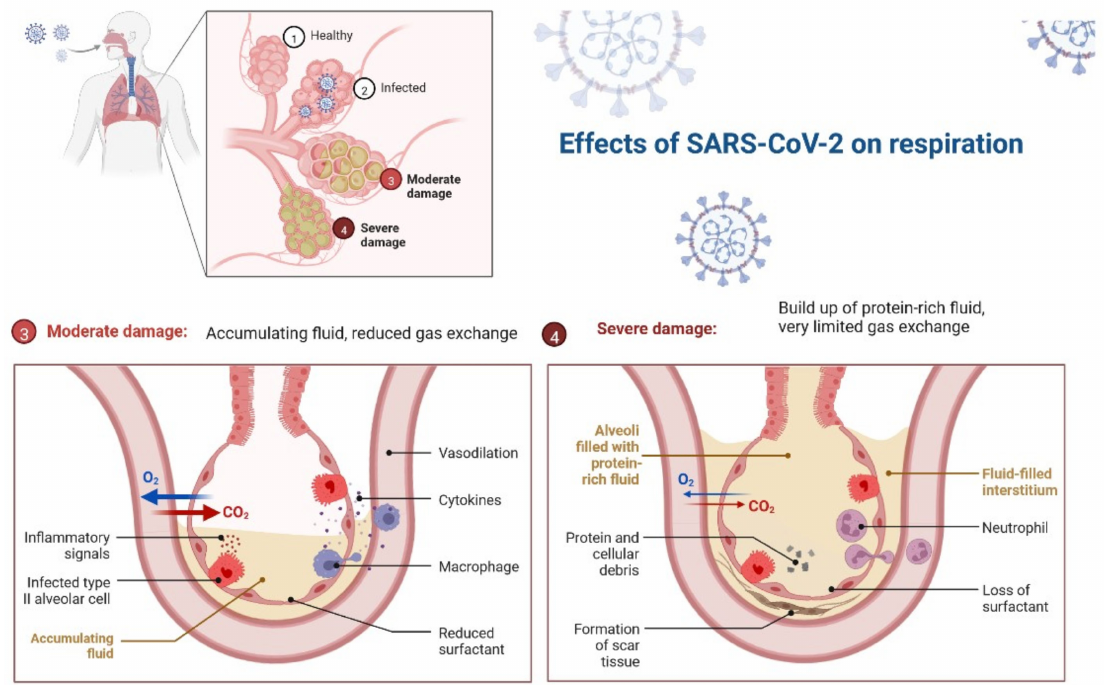
Figure 7. After entering the body through the mouth or nose, SARS-CoV-2 makes its way into the lungs, where it uses its distinctive spike proteins to infect alveolar cells. In response, the immune system attacks the area of infection, killing healthy alveolar cells in the process. Reduced surfactant from alveolar epithelial type II cells, along with increased fluid accumulation in the alveoli, causes reduced or severely hindered gas